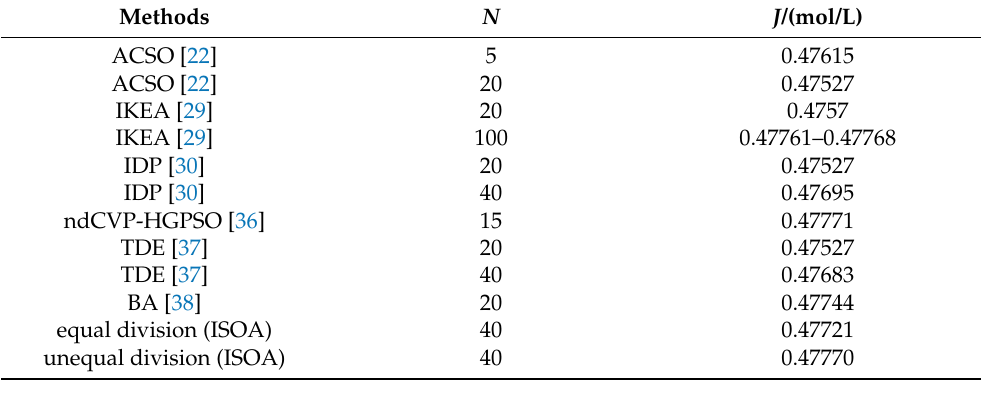
Table 4. Comparison of methods of tubular reactor.